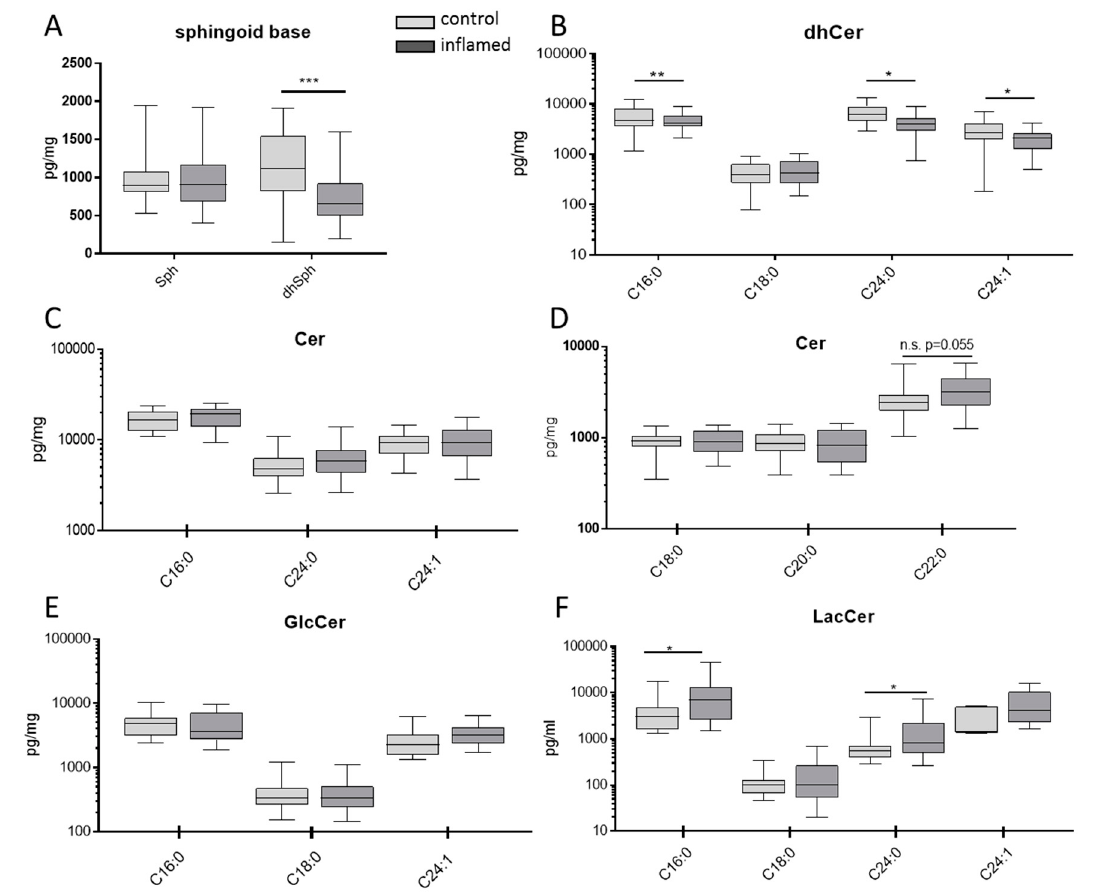
Figure 2. Sphingolipids in colon tissue. Colon samples from inflamed and control tissue were collected from UC patients undergoing diagnostic colonoscopy and sphingolipid concentrations where analyzed by LC–MS/MS. n = 27. Statistical differences were analyzed by a paired T-test, α = 0.05, (* p < 0.05, ** p < 0.01, *** p < 0.001).